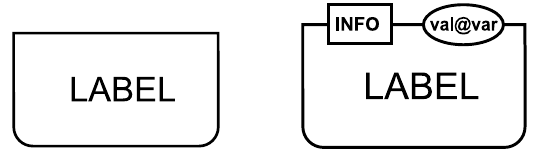
Figure 2.11: The Process Description glyph for nucleic acid feature , shown plain and un- adorned on the left and with an additional state variable and a unit of information on the